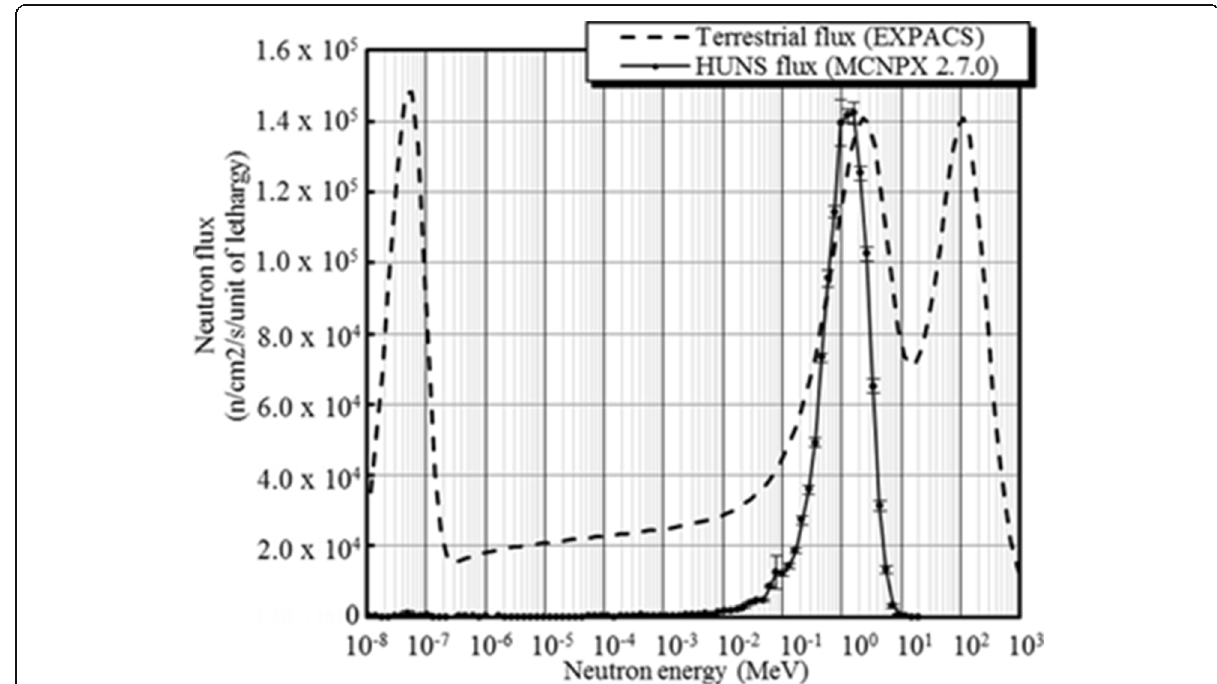
Fig. 15 Comparison of simulated spectral neutron flux data for the HUNS facility (solid line and symbols) and for the natural terrestrial environment at Tokyo, Japan, at sea level (dashed line) [42]